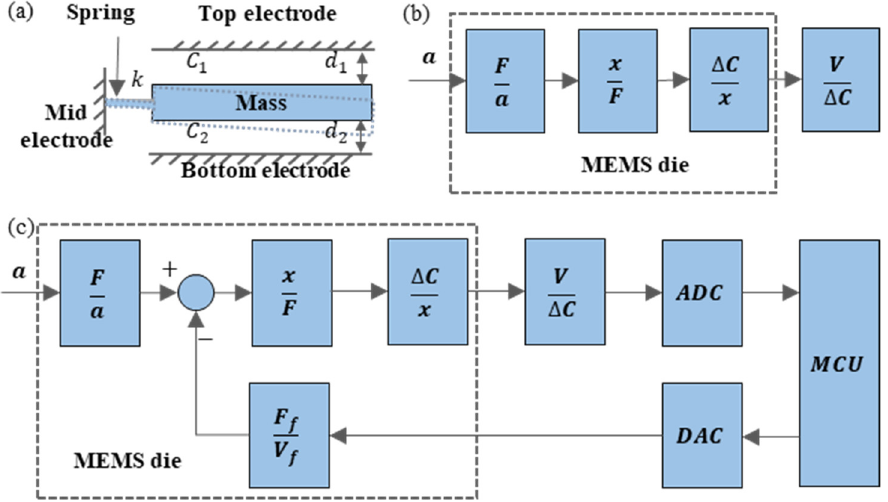
Figure 2. Parallel-plate capacitive accelerometer: ( a ) MEMS capacitive accelerometer structure, ( b ) acceleration-sensitive principle, and ( c ) closed-loop detection scheme of the accelerometer.